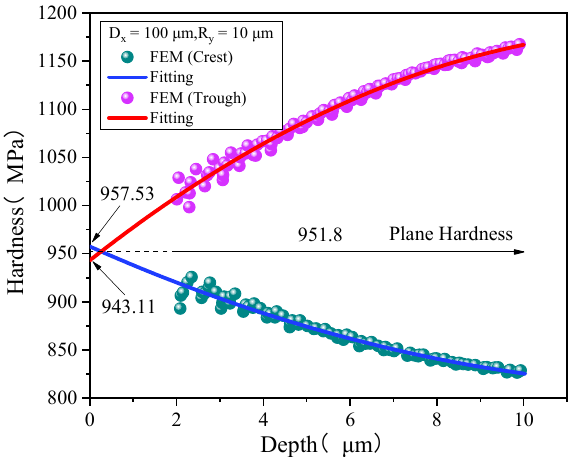
Figure 11. Hardness regression of crest and trough. The characteristic sizes of the sinusoidal surface are D x = 100 μm and R y = 10 μm.